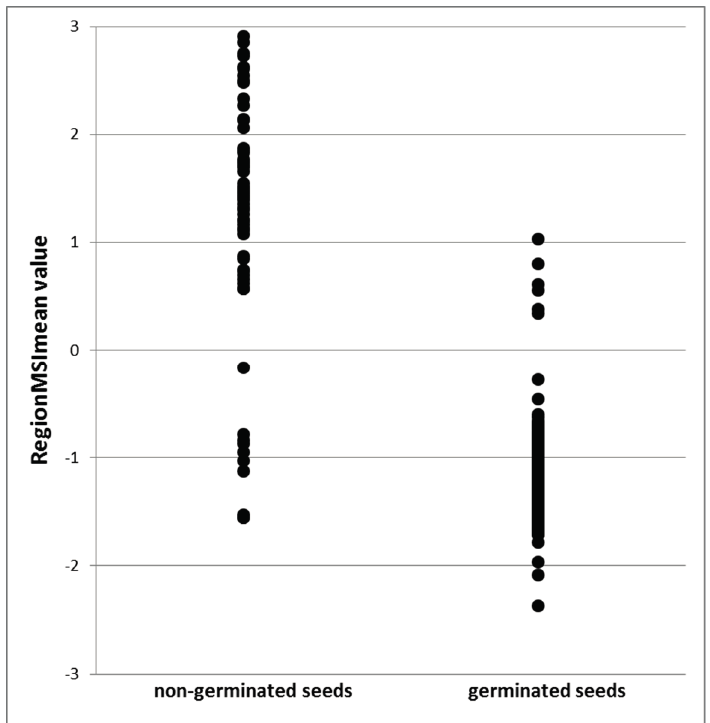
Figure 6. Positive RegionMSI meanvalues is predicted in the model as dead seeds and negative values predicted in the model as viable seeds. Seeds evaluated for germination after 6